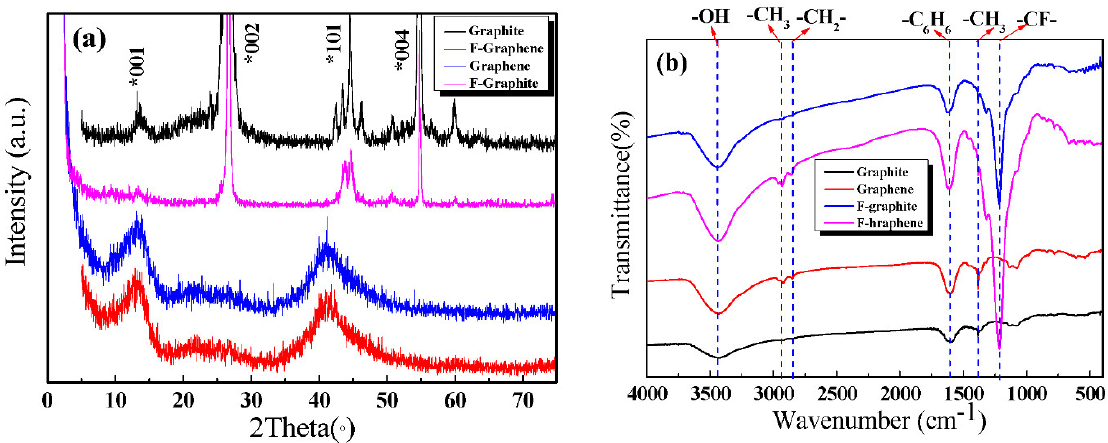
Figure 3. The XRD and FTIR analysis of four carbon materials. ( a )XRD, ( b ) FTIR.